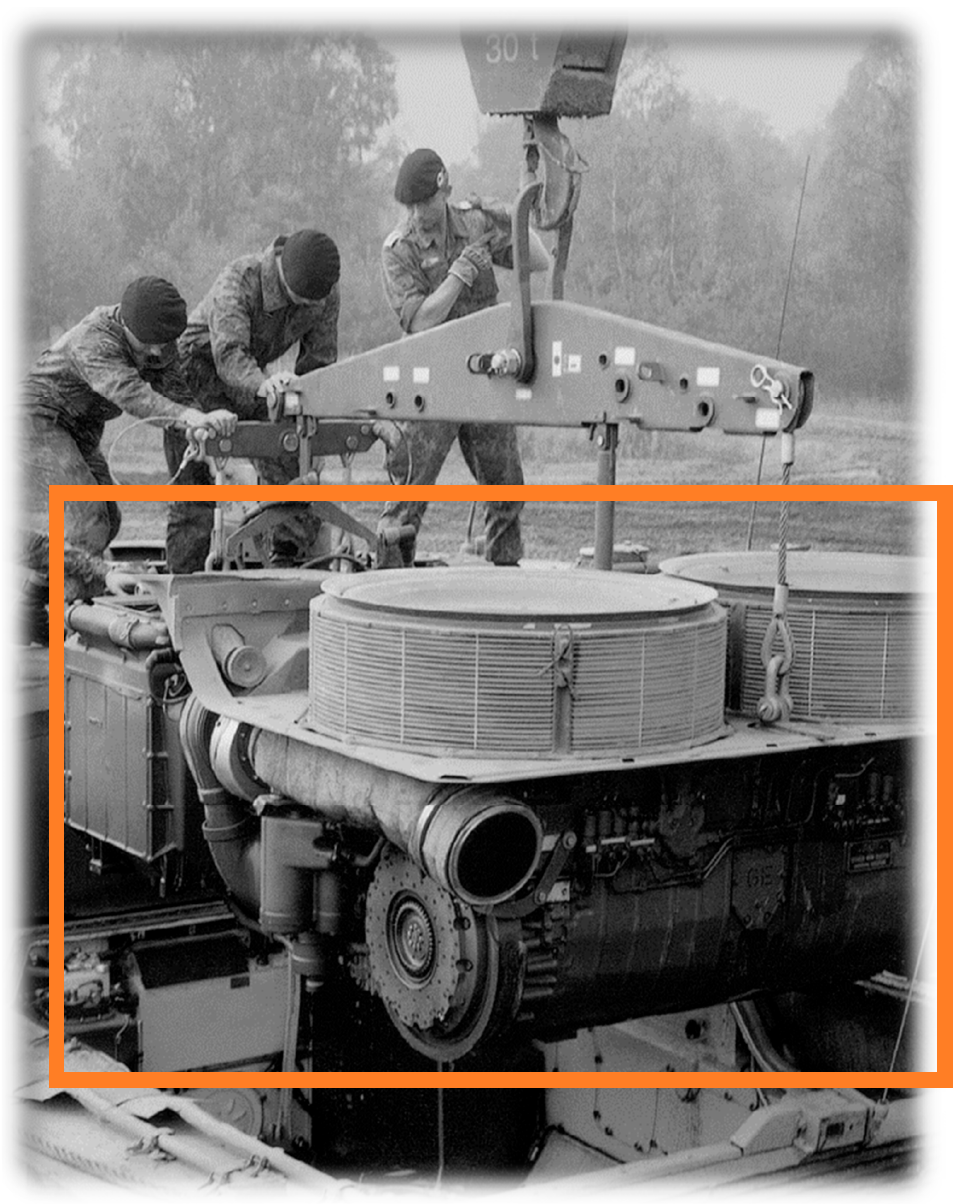
when the impeller and the turbine begin to synchronize (acceleration).